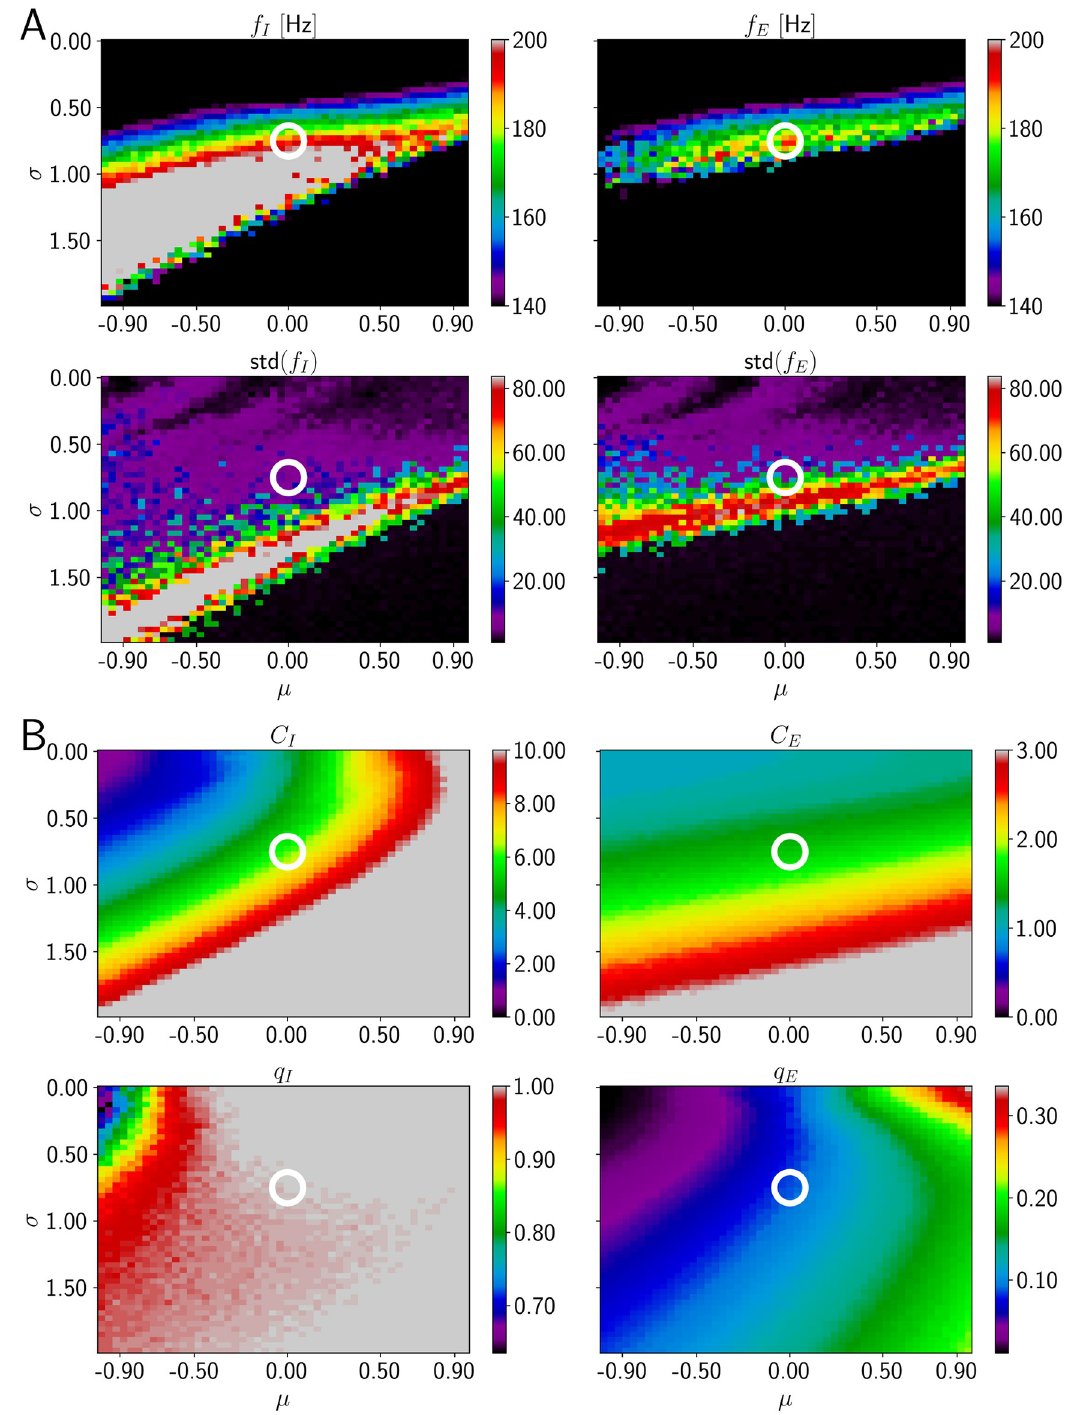
Fig 8. HFOs in networks incorporating dendritic excitation (model 3). In the parameter space of the distribution for the peak dendritic current, a region with reliable ripple oscillation generation and sparse spiking of E neurons exists in model 3. The layout of the figure is similar to Fig 4; the changed variables are now the parameters μ and σ of the lognormal distribution of dendritic spike impacts on the soma (Eq 2). A: Network frequencies and standard deviations as a function of μ and σ (Eq 2). The range displayed in detail by different colors is the ripple range, [140, 200] Hz. Frequencies above and below are shown in gray and black. B: Number of spikes per active neuron and fraction of active neurons. The displayed ranges for C above are colored in gray. The white circle is located at ( σ , μ ) = (0.75, 0.0), the parameter values of Fig 7.